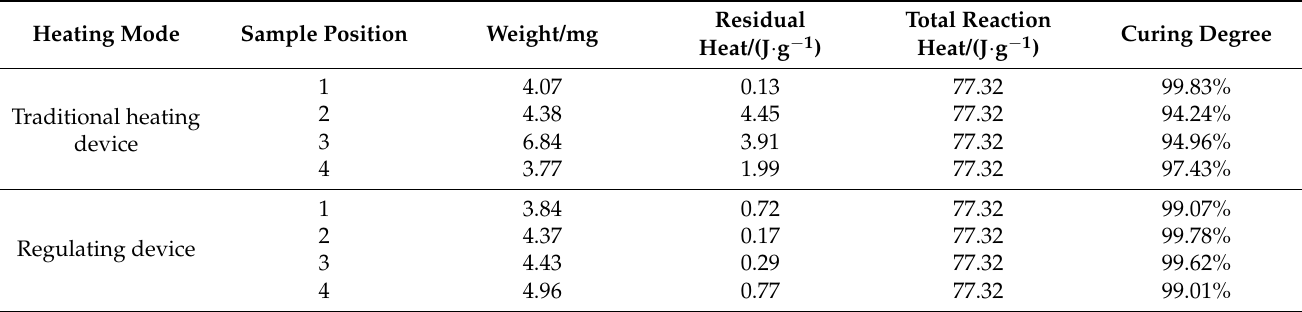
Table 3. Curing degree of different samples.